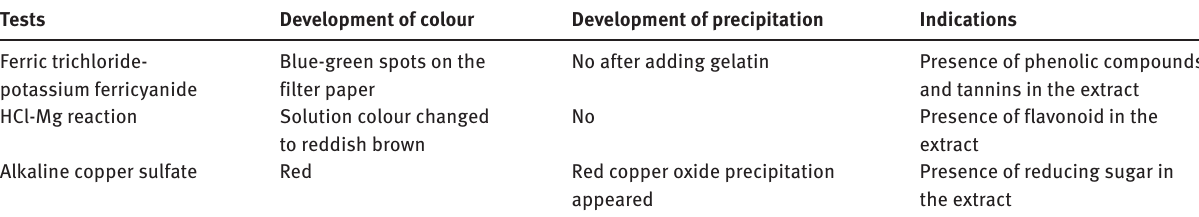
Figure 1: The results of the influencing factors for the optimisation of extraction conditions on the basis of antioxidant capacity (Fe 3 + mmol/l) (A) mass of plant leaves (g) per 80 ml (B) temperature (K) (C) contact time (min) and (D) pH. Table 1: The colour development tests to investigate the presence of organic contents in the leaves extract of Fraxinus chinensis Roxb